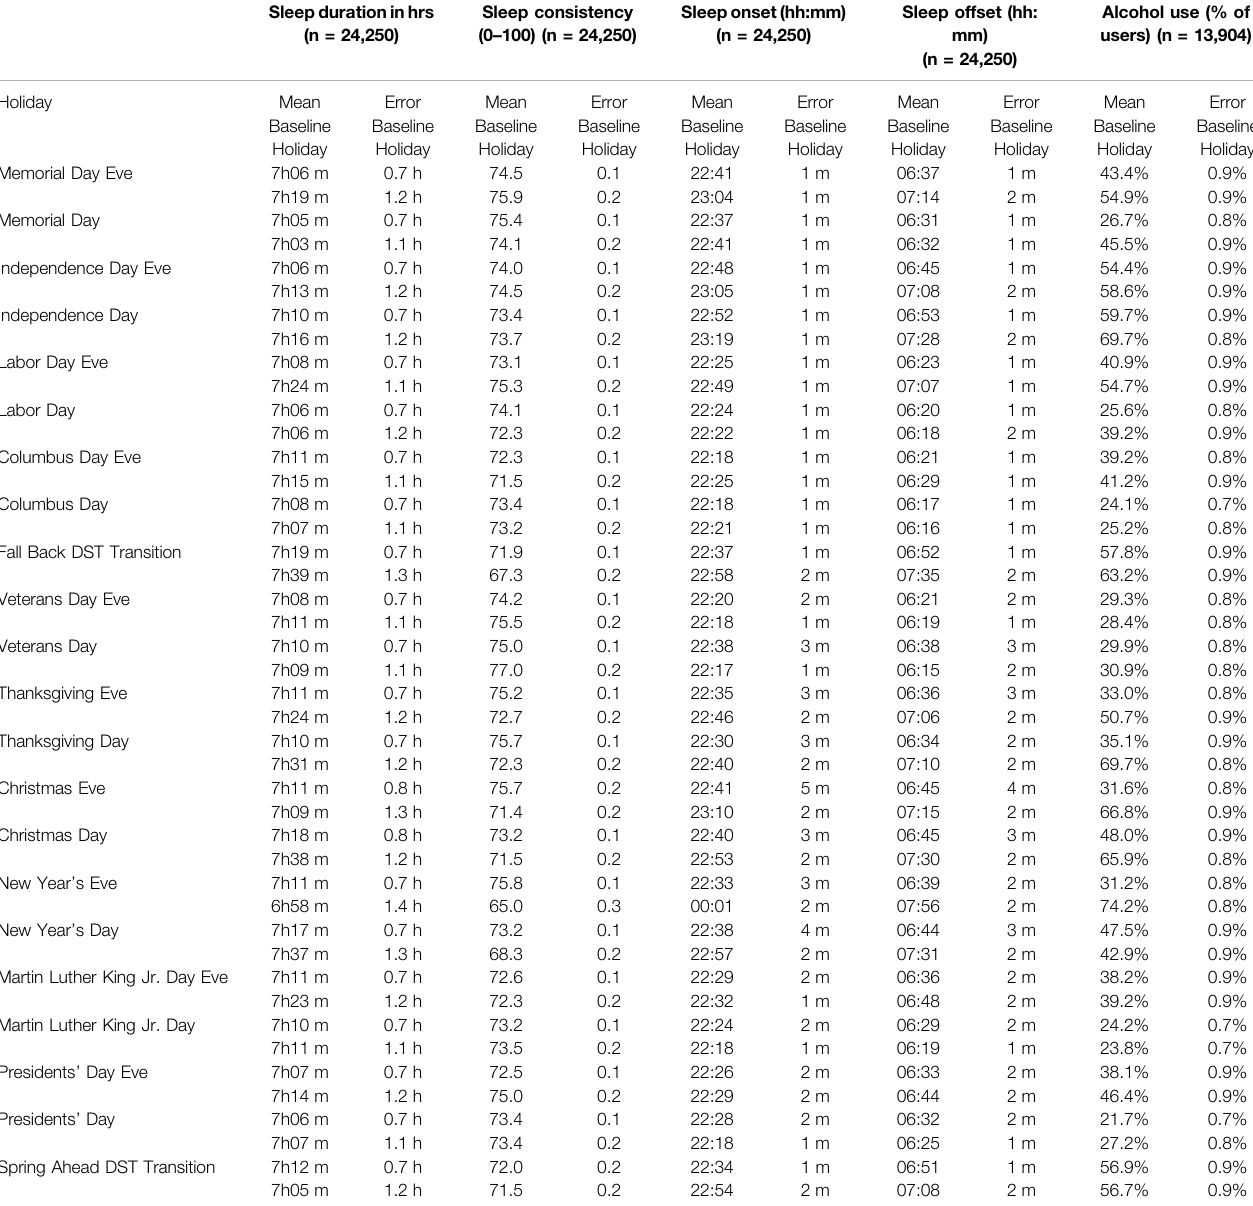
TABLE 2 | Sleep and alcohol use patterns at baseline and during DST transitions and on holidays and their eves.